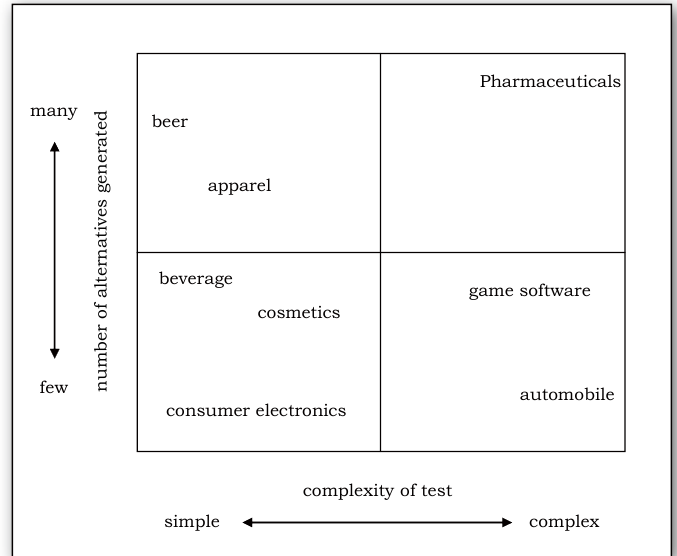
Figure 1. Problem-solving